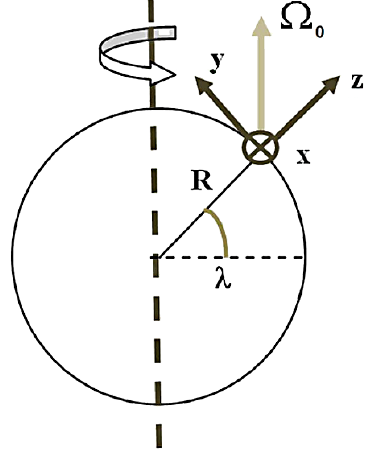
Fig. 1. Coordinate system of the model. X axis pierces the plane of figure. R is the radius of the Earth, (cid:127) 0 is the angular velocity of the Earth rotation; λ = 0 and λ = π/ 2 correspond to equator and pole,